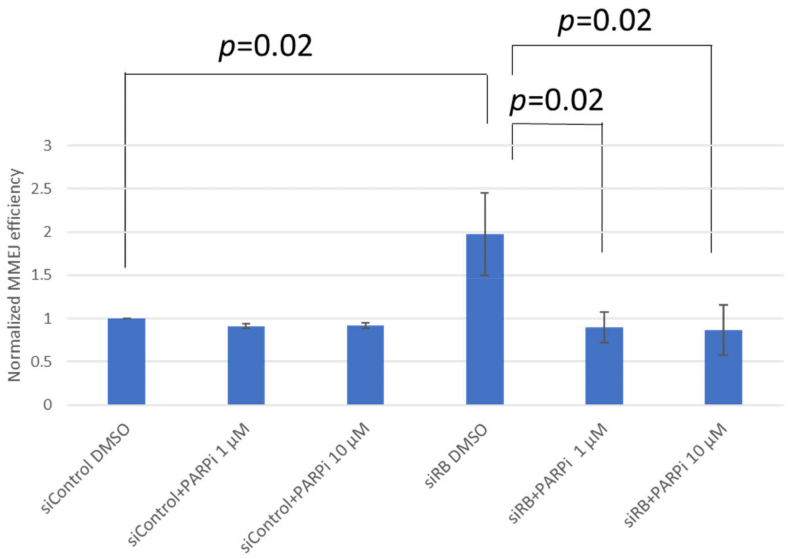
Figure 1. MMEJ efficiency was measured in non-targeting control siRNA (siControl) and RB siRNA (siRB)-transfected U2OS cells. Cells were also treated with DMSO, 1 µ M or 10 µ M olaparib (PARPi) for 1 h. Experiments were repeated three times. Data are shown as mean ± standard deviation and analyzed using two-tailed unpaired t -test.